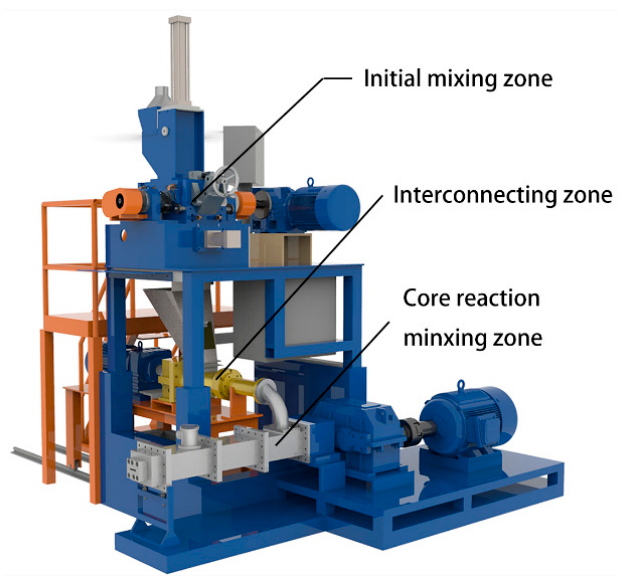
Figure 2. Integral structure of the serial modular continuous mixer.